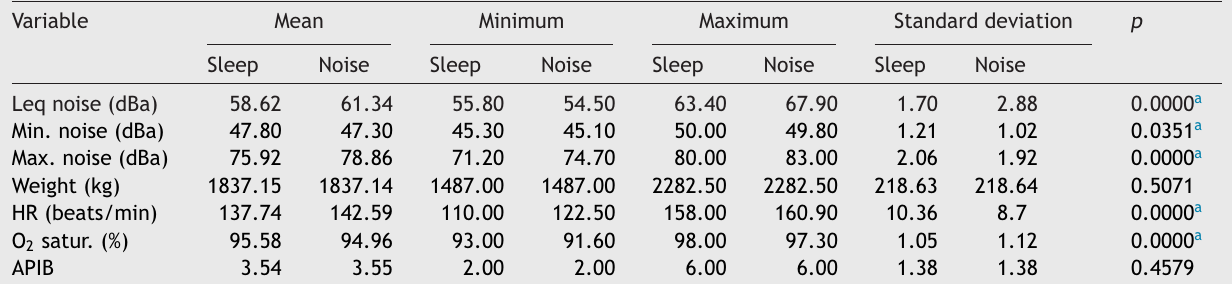
Descriptive statistics of the variables analyzed and comparison between groups: S and R ( n = 61).